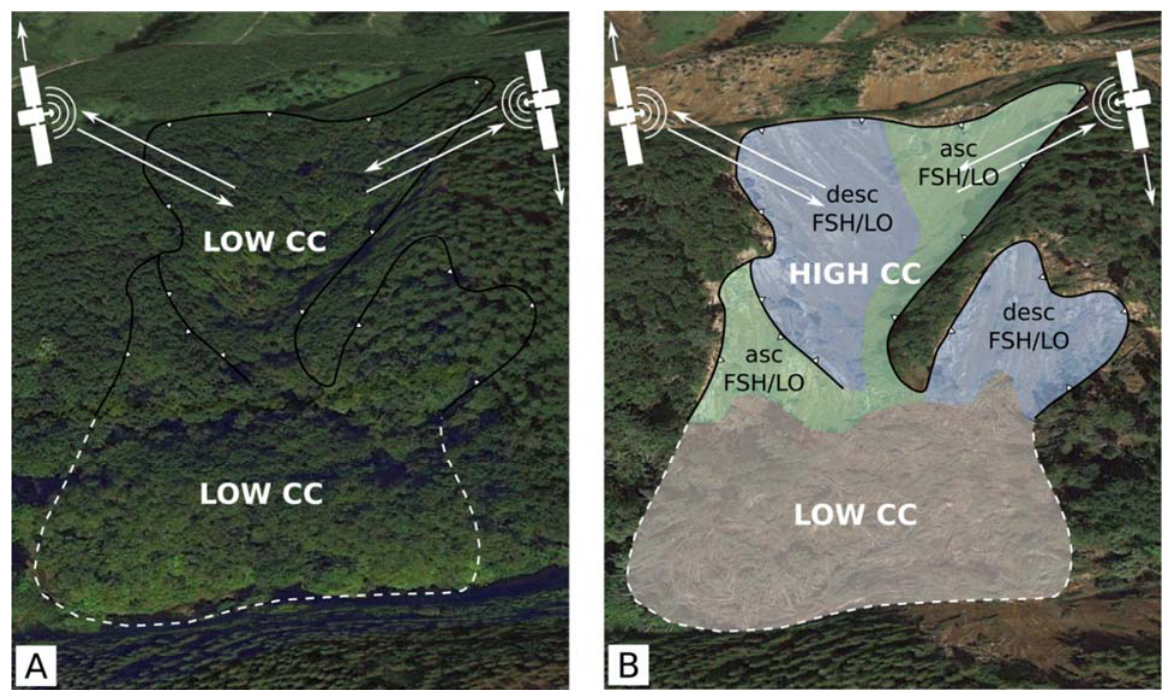
Figure 5. Sketch of coherence changes and the limitations induced by the acquisition geometries triggered by suddenly developed landslide in Hokkaido. ( A ) = pre-event optical image; ( B ) = post- event optical image; CC = coherence; asc. = ascending; desc. = descending; FSH/LO = expected foreshortening/layover according to the geometry. The dashed line indicates the mass of the landslide, while the zig ‐ zag line represents the main scarps.